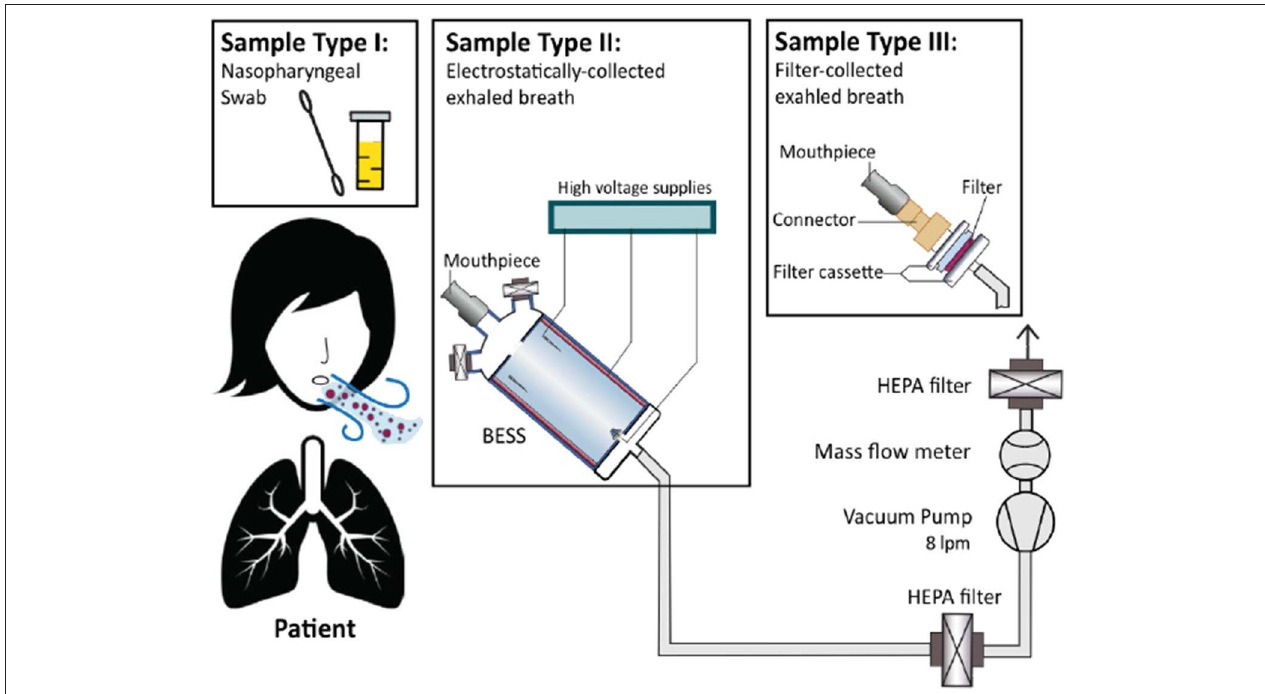
FIGURE 1 | Experimental setup and study design. Three sample types were collected from each patient: a nasopharyngeal (NP) swab, breath aerosol sample using the BESS device, and a breath aerosol sample using a gelatin filter.